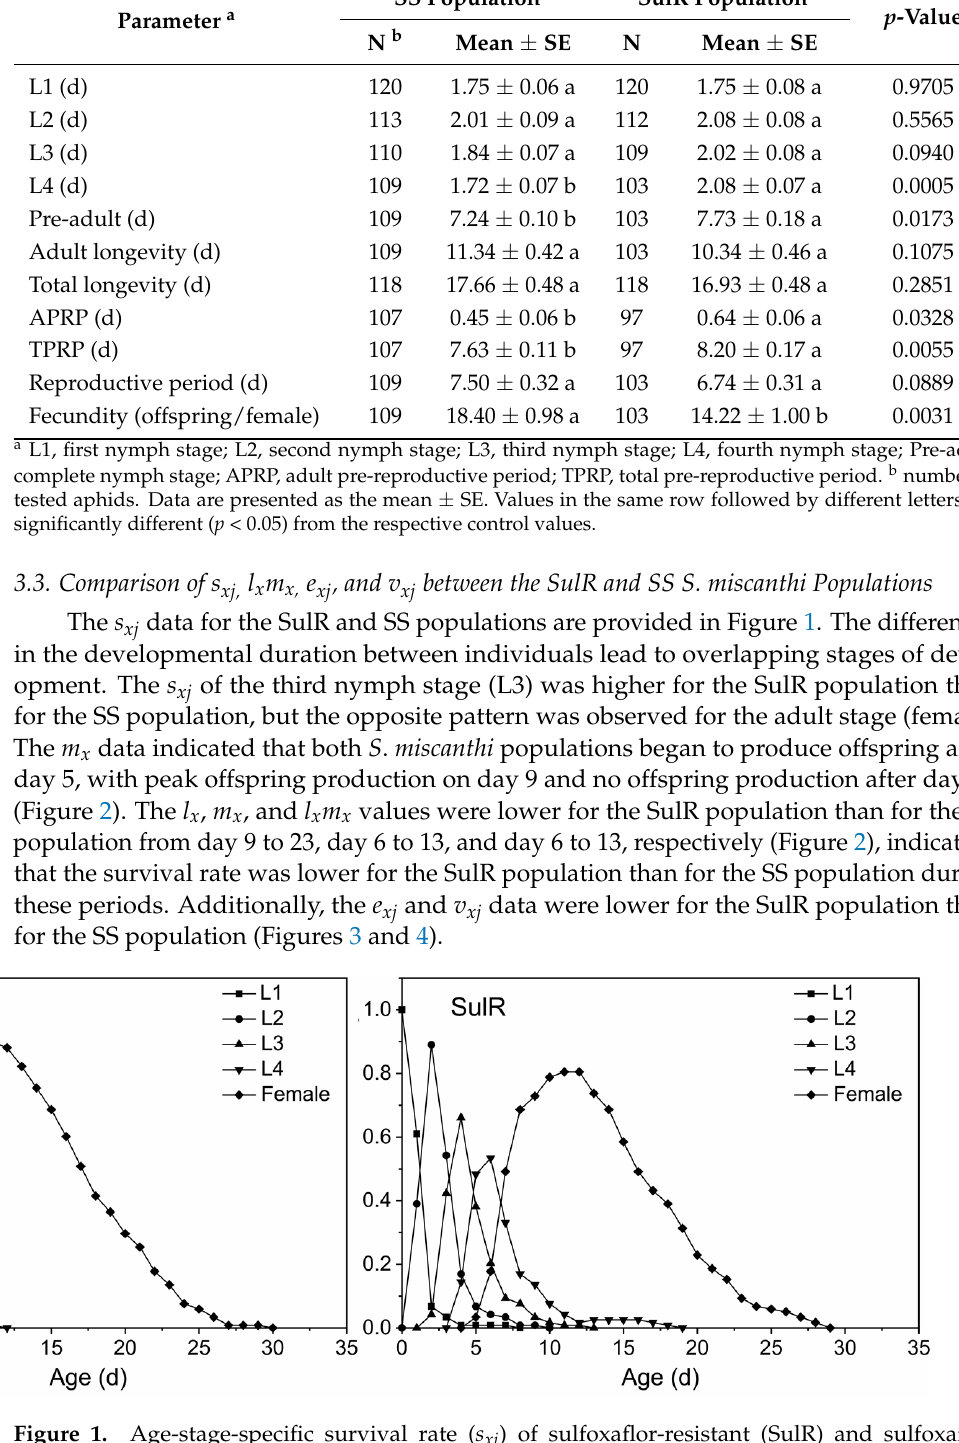
Table 2. Developmental duration and fecundity of sulfoxaflor-susceptible (SS) and sulfoxaflor-re- sistant (SulR) Sitobion miscanthi populations.